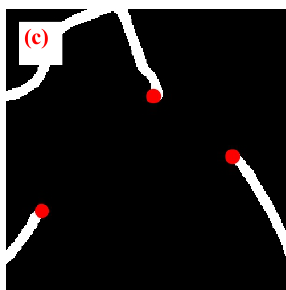
Figure 1. Breakpoint types. (a)non-matching breakpoint. (b) the only matching breakpoint. (c) multi-value matching breakpoint